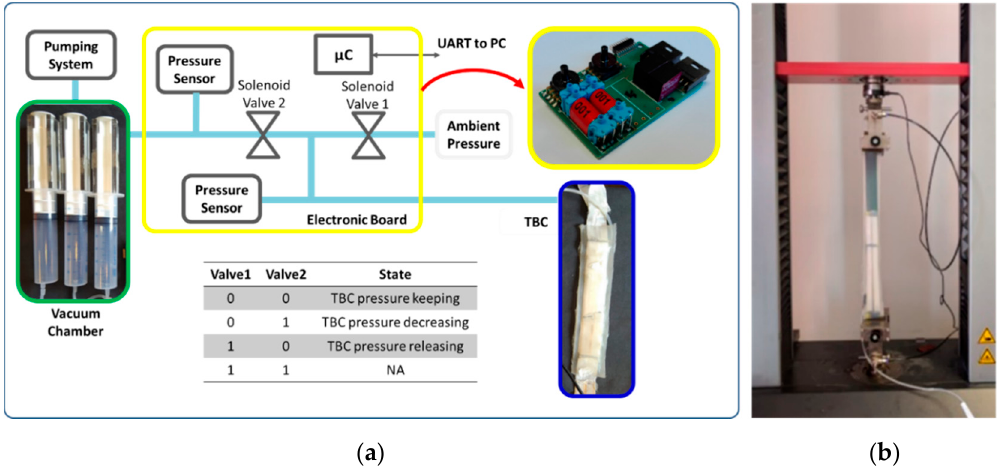
Figure 5. ( a ) The control unit; two valves control the pressure inside the TBC. A chamber is used as the vacuum reservoir and enables several activations of the TBC without the direct use of a vacuum pump; ( b ) Mechanical testing machine used to experimentally evaluate the TBC engaging